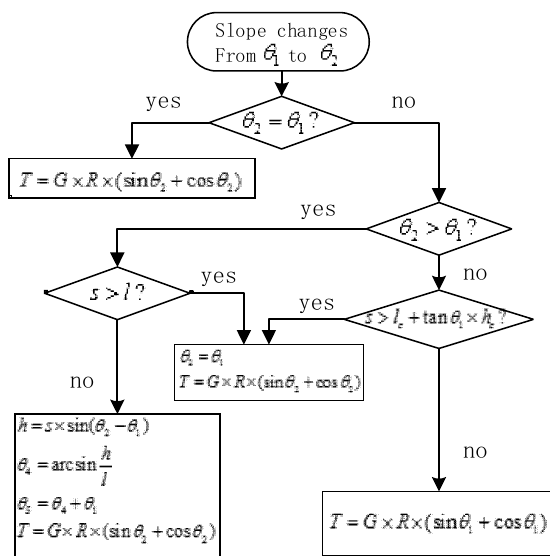
Figure 4. Chart of car body inclination angle and resistance moment analysis.